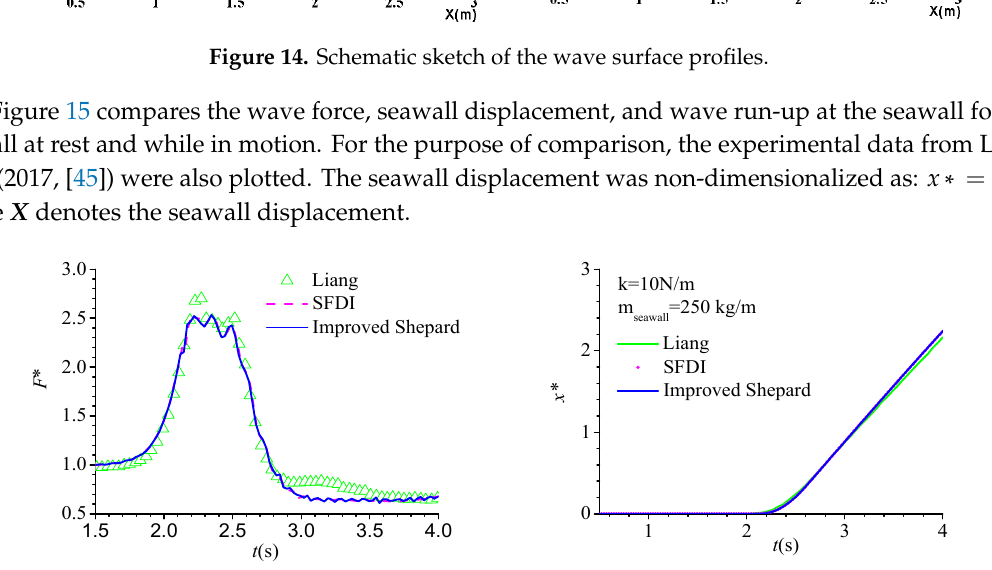
Figure 15. Comparison of the non-dimensional impact force ( left ) and seawall displacement ( right ) for the seawall at rest and while in motion with numerical data from Liang et al. (2017, [45]).